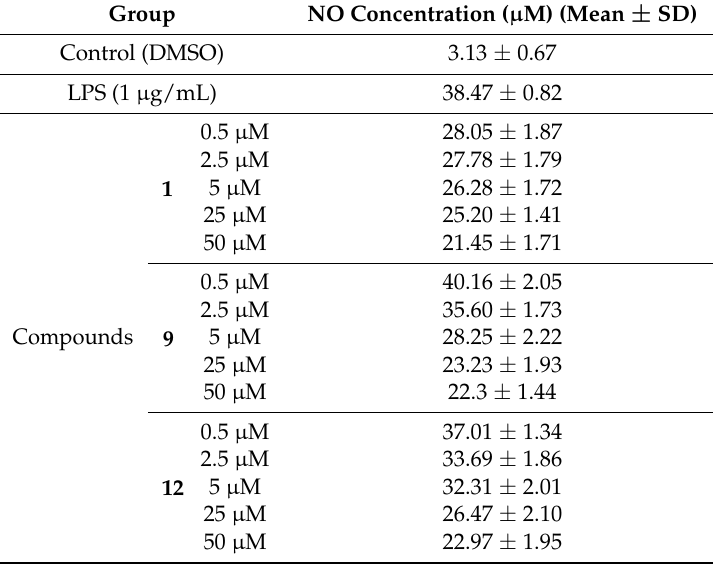
Table 2. The NO production of isolated compounds at different concentrations in LPS-stimulated RAW 264.7